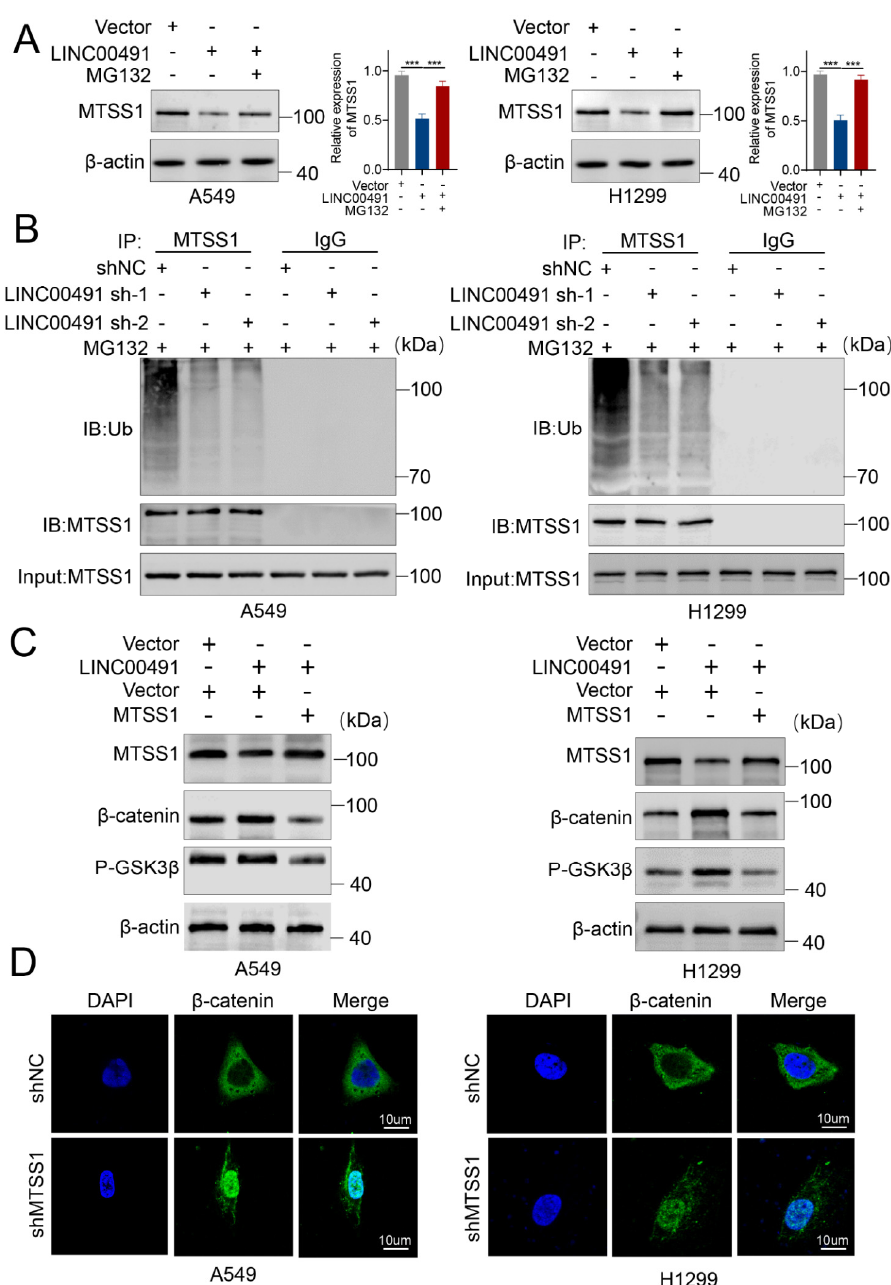
Figure 4. LINC00491 activates the Wnt-signaling pathway via promoting the ubiquitin–proteasome degradation of MTSS1. ( A ) Western blot showing MTSS1 protein in LINC00491 overexpressed LUAD cells treated with MG132 (5 µ M) for 24 h. Quantification of results is exhibited in the right panel. ( B ) Ubiquitinated MTSS1 immunoprecipitated with anti-MTSS1 antibody or IgG control and immunoblotted with an anti-ubiquitin antibody in LUAD cells in the shNC and shLINC00491 groups treated with MG132. ( C ) Western blot analysis of Wnt/ β -catenin and p-GSK3 β protein expression in A549 and H1299 cells transfected with LINC00491, and/or MTSS1. Mock plasmids served as control. ( D ) Representative images of immunofluorescence indicating the expression and subcellular localization of β -catenin (green) in LUAD cells transfected with shNC, or shMTSS1. The nucleus was counterstained with DAPI (blue). In each experiment, three replicates were conducted. Data are presented as the mean ± SD. ***, p <